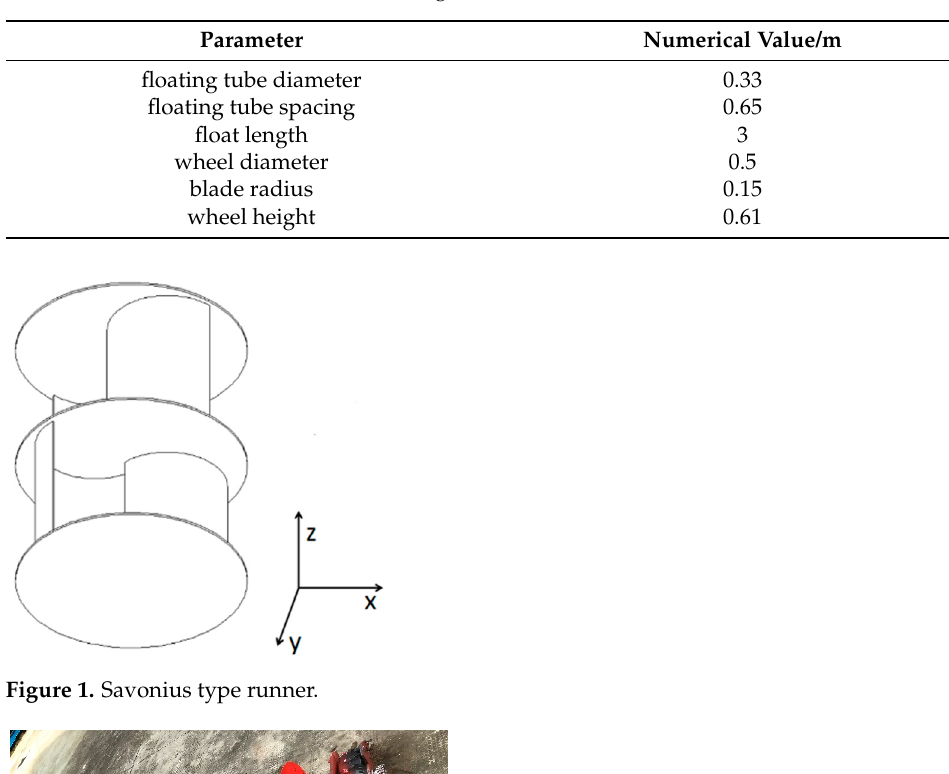
Table 1. Geometric characteristics of floating breakwater.